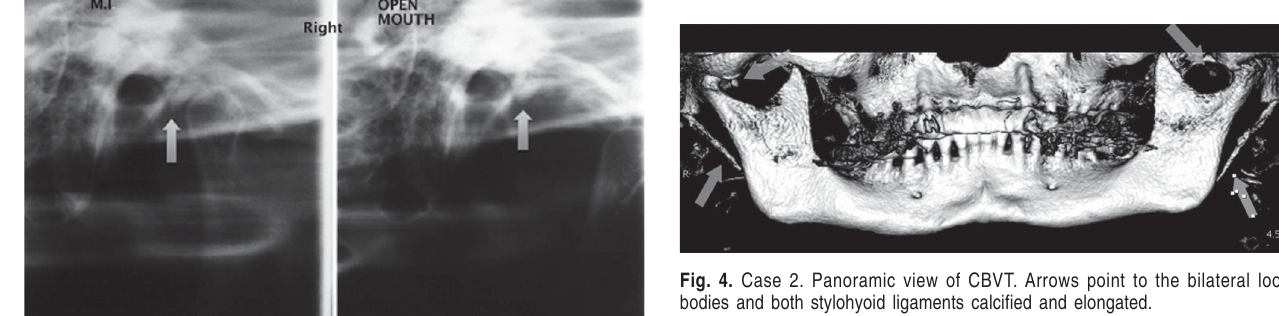
Fig. 1. Case 1. Orthopantomograph of right TMJ: Maximum intercuspation (MI) and open mouth. Arrows point to the loose bodies.